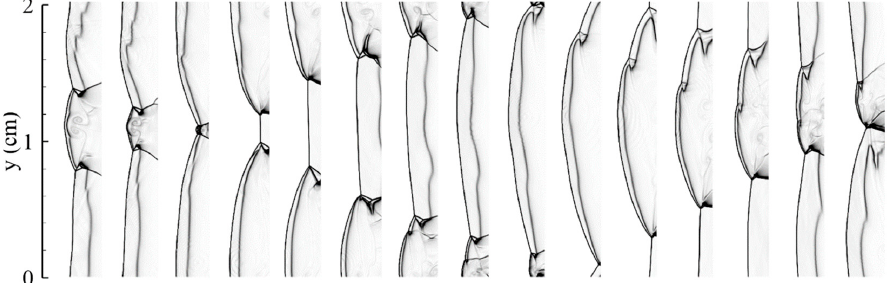
Figure 11. Density gradient of the detonation front from x = − 52.875 to x = − 56.25. Detonation prop- agates from right to left.